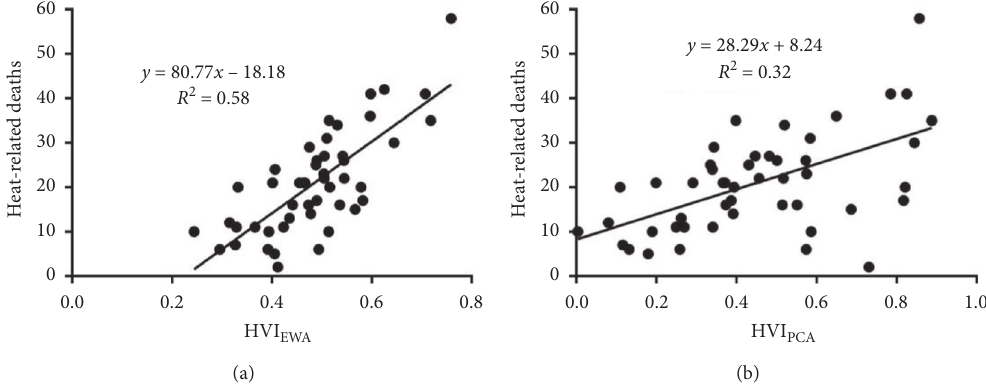
Figure 7: The correlation between the heat-related deaths and (a) HVI